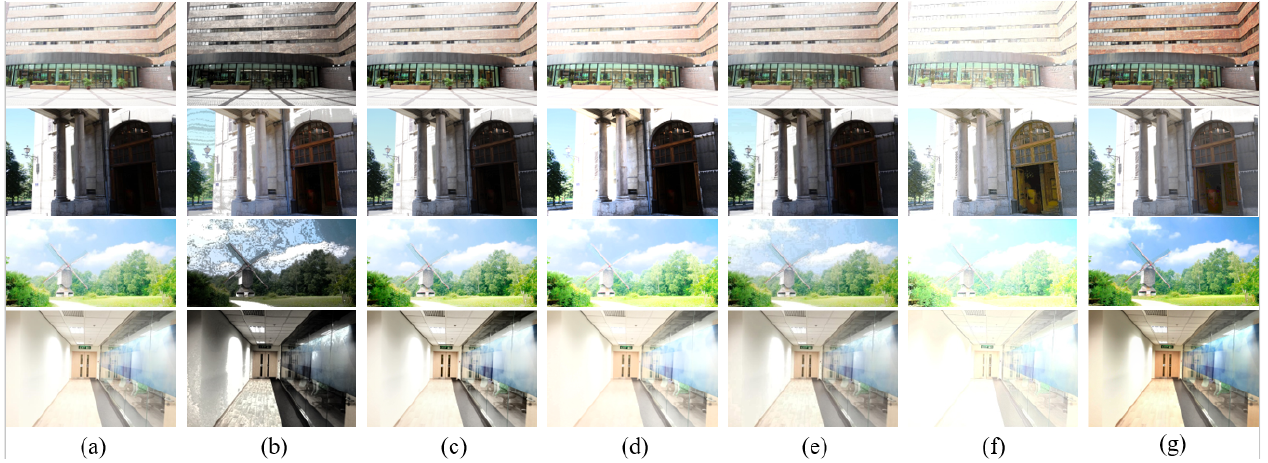
Figure 6. Comparison of single image enhancement results using different algorithms. ( a ) Input image; the enhanced results obtained using ( b ) HE [25], ( c ) CVC [26], ( d ) AGCWD [27], ( e ) EPMP [28], ( f ) SICE [14], and ( g ) the proposed method (fusing I and I γ